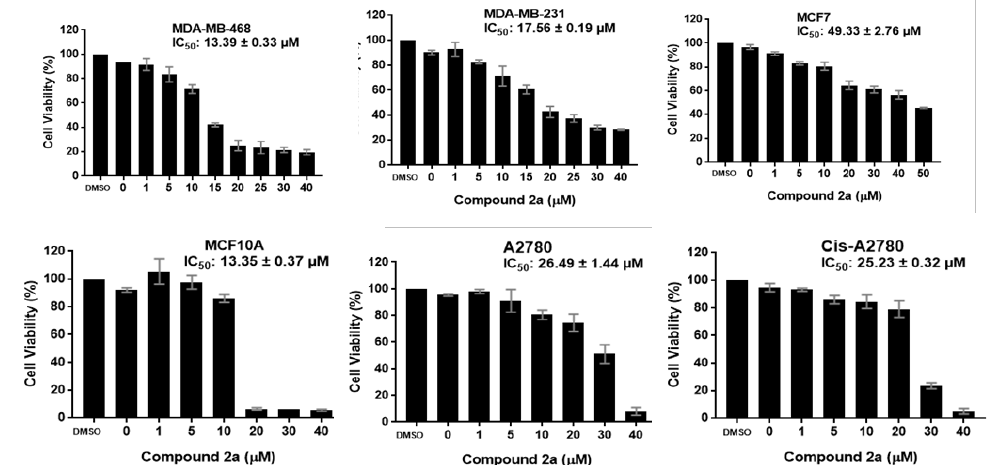
Figure 4. The cell viability (%) relative to untreated control cells of selected breast and ovarian cancer cell lines and breast normal (MCF10 A) cell line following the exposure of various concentrations of compound 2a for 48 h.